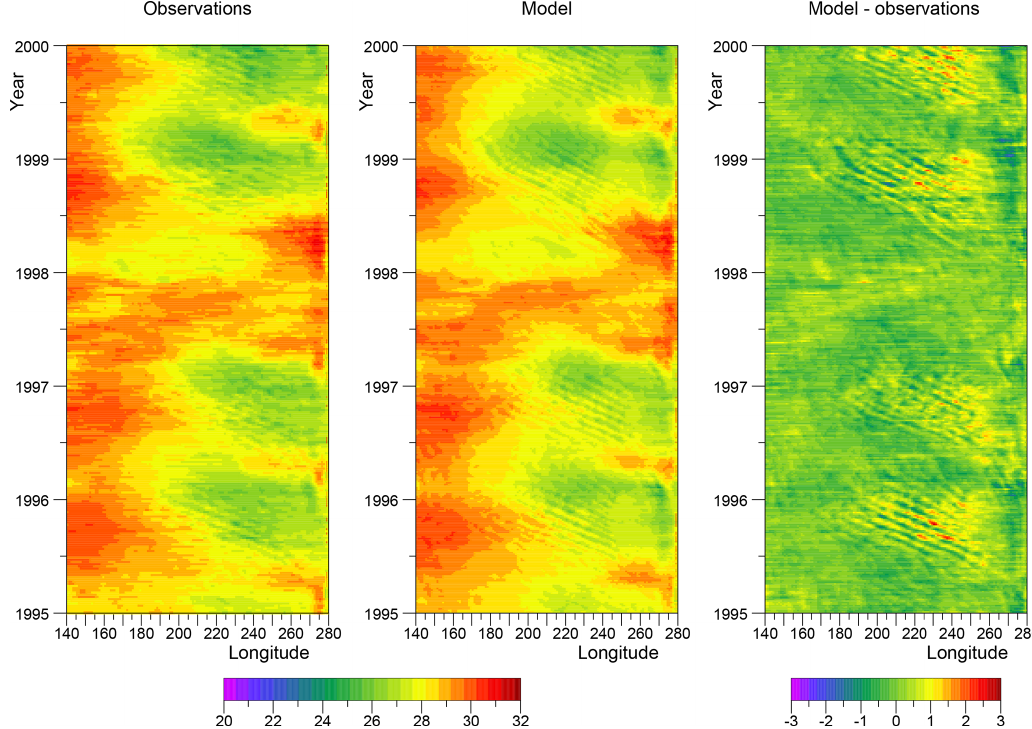
Figure 2. Observed and model sea surface temperatures and their difference, averaged between 3 and 9 ◦ N, for the equatorial Pacific between 140 and 280 ◦ E (80 ◦ W). Units are degrees Celsius.